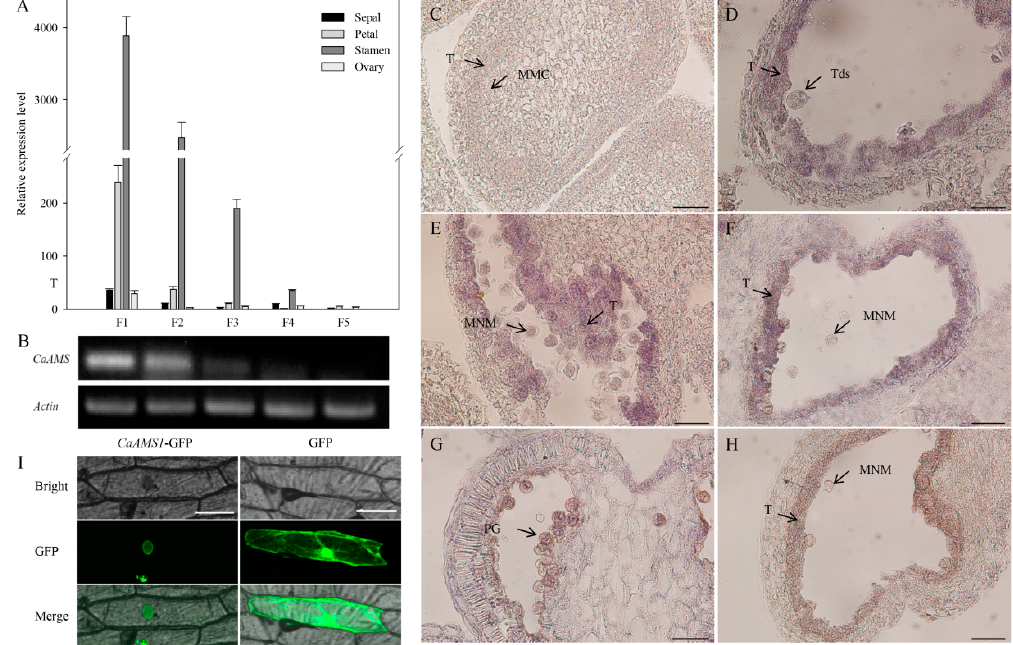
Figure 2. Expression analysis of CaAMS in flower buds and subcellular localization of CaAMS1 protein. ( A ) qRT-PCR analysis of CaAMS in flower buds at various developmental stages. F1, F2, F3, F4, and F5 indicate flower buds at tetrad, early-mid uninucleate, late uninucleate, binucleate, and maturing stages, respectively. Data are represented as means ± SD ( n = 3). ( B ) Semi-quantitative RT-PCR analysis of CaAMS in stamens at various developmental stages (same as in qRT-PCR analysis). ( C – H ) RNA in situ hybridization with the CaAMS probe. ( C ): CaAMS signal cannot be detected in tapetum at pollen mother cell stage. ( D – F ) Strong signal is detected in the tapetum at the tetrad and uninucleate stages. ( G ) CaAMS signal cannot be detected at pollen mature stage. ( H ) The negative control in the uninucleate stage. Only background signal can be detected. T indicates the tapetum; Td indicates the tetrad; MMc indicates the microspore mother cell. MNM indicates the uninucleate microspore. PG indicates the pollen grain. Bar = 200 µ m. ( I ) Subcellular localization of CaAMS protein in onion epidermal cells. Bars = 100 µ m.